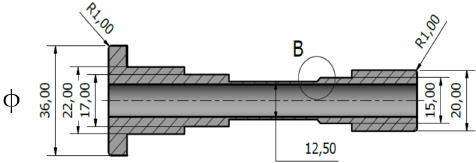
Figure 1. SPB Front and longitudinal view.